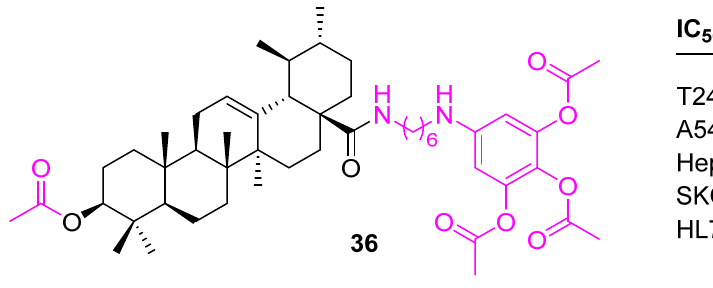
Figure 23. Structure of 36 .